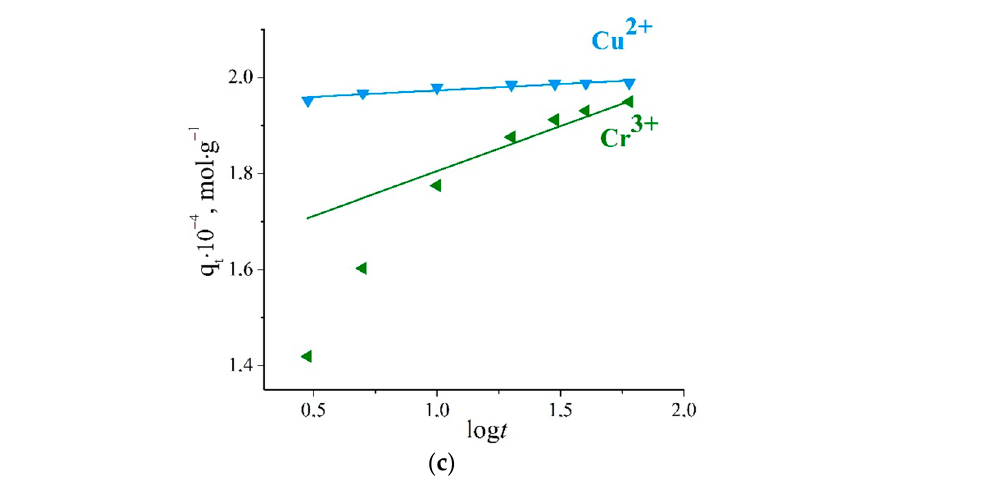
Figure 10. Elovich kinetics plot for adsorption of studied ions on titanium phosphate at 298 K ( a , c ) and 303 K ( b ).